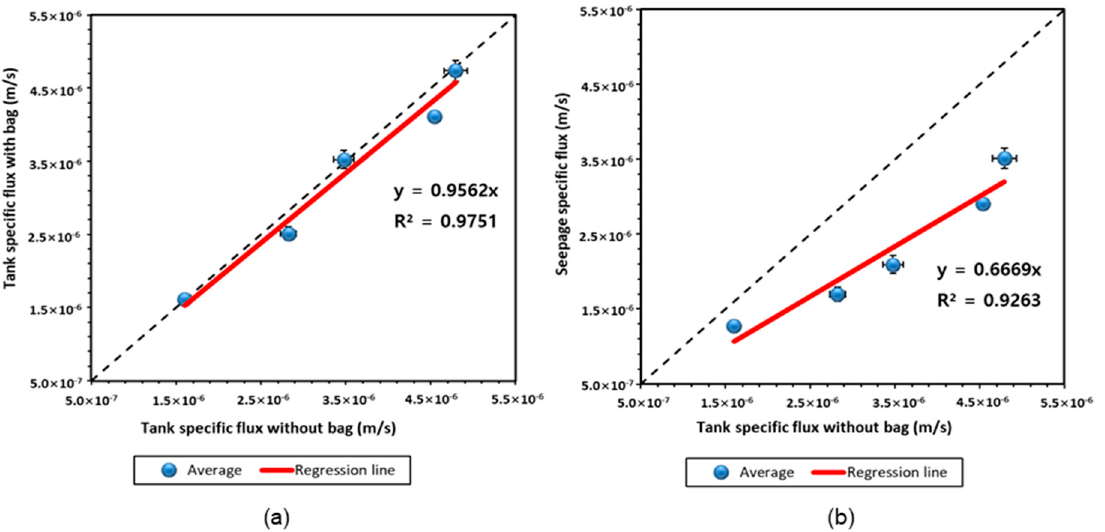
Figure 4. Comparison of ( a ) the tank specific influx rates with and without the collection bag and ( b ) the tank specific influx rate and the seepage specific influx rate measured using the Type 1 collection bag. Error bars represent the standard deviations for five experiments at each head difference (see Table 2).